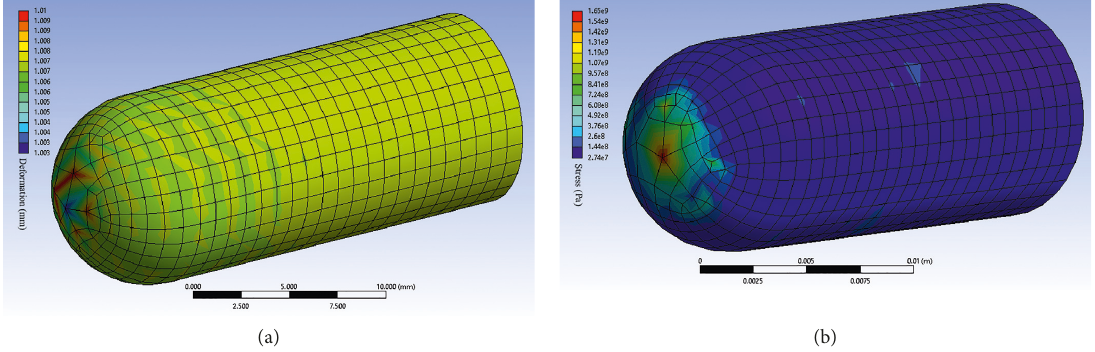
Figure 17: Deformation (a) and Von Mises stress distribution (b) of solid diamond TBM button.